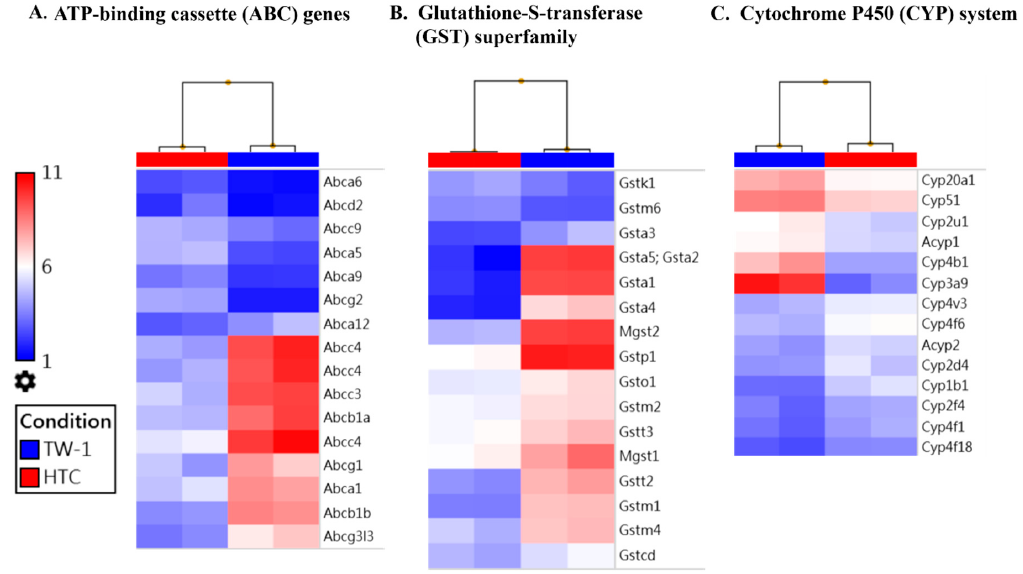
Figure 3. Expression of drug resistance gene families in HTC and TW-1 cells. The drug resistance genes overexpressed in the TW-1 cells included ( A ) ATP-binding cassette (ABC), ( B ) glutathione-S-transferase (GST) superfamily, and ( C ) cytochrome P450 (CYP) system.